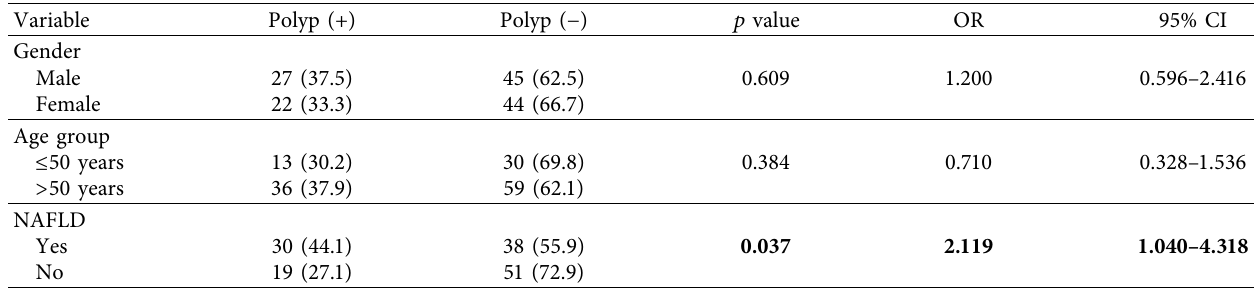
Table 3: Associations among clinical variables and colon polyps ( n �